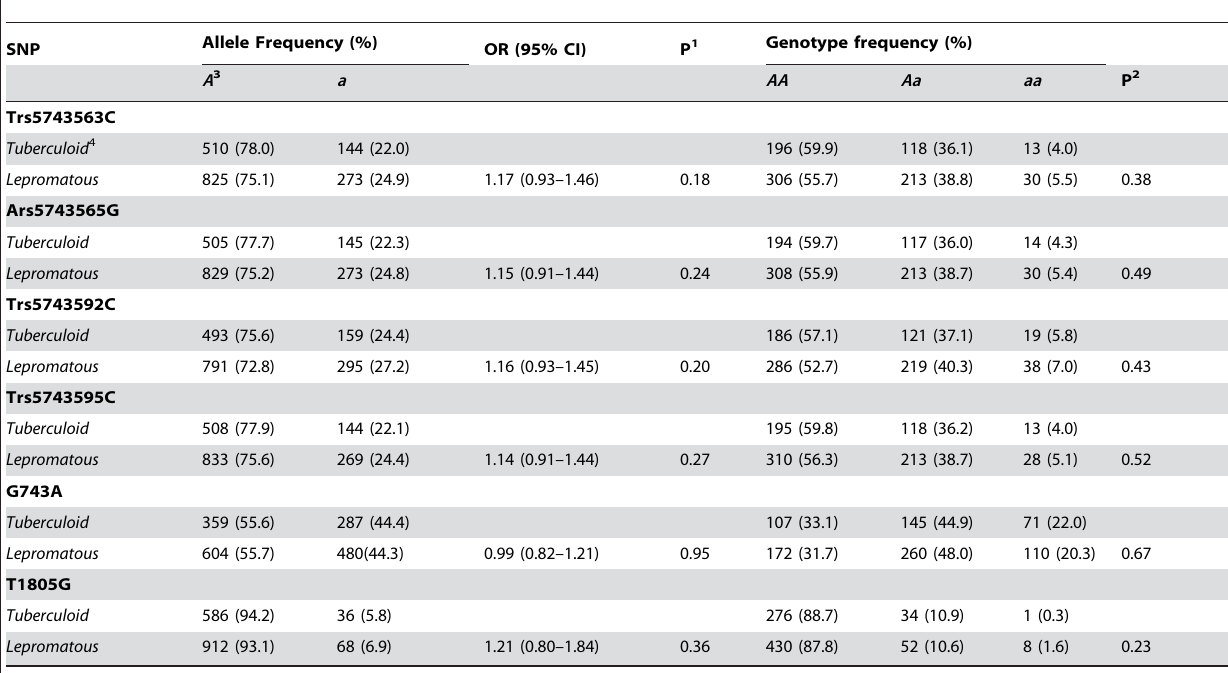
Table 2. TLR1 Polymorphism Frequency in Different Leprosy